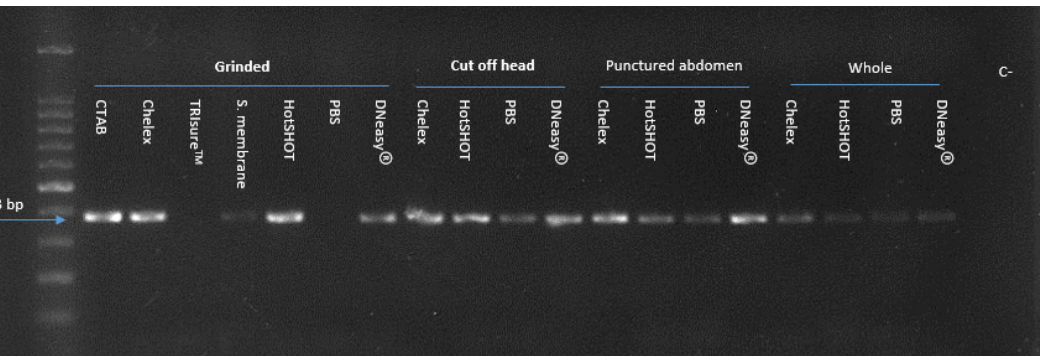
9 of 19 Table 3. Comparison of DNA yield ratios * expressed in ng·mg − 1 (mean ± SE, n = 14) of the speci- men preparation procedures in four DNA extraction methods. Specimen Preparations DNA Extraction Methods Chelex